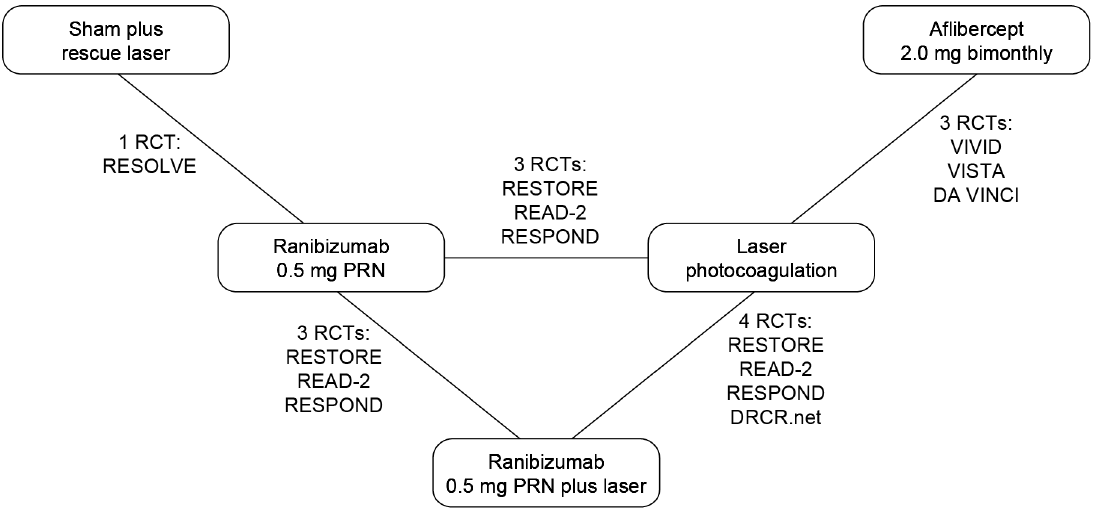
Figure 2. Study network .